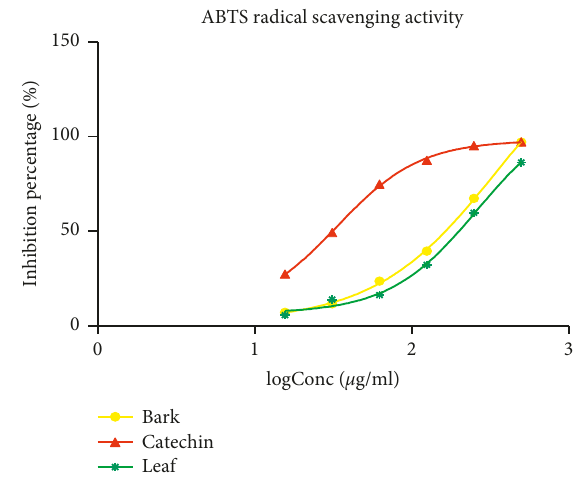
Figure 3: ABTS scavenging activity of the hydro-ethanolic leaf and bark extracts of Psychotria densinervia and ascorbic acid. Values are mean ± SD ( n � 3).